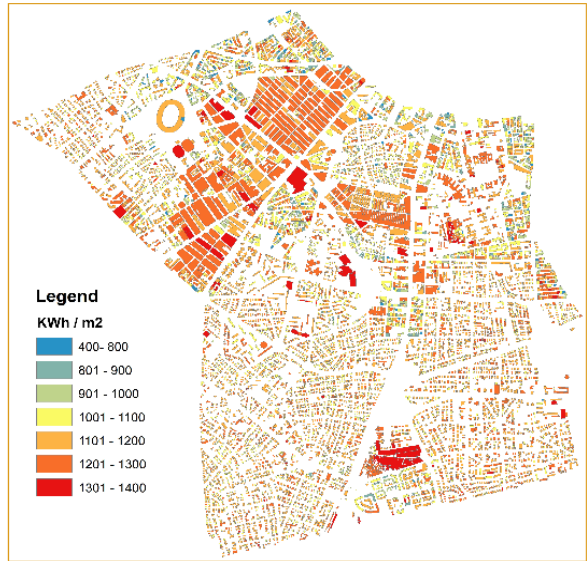
Figure 4. Global average annual solar radiation.